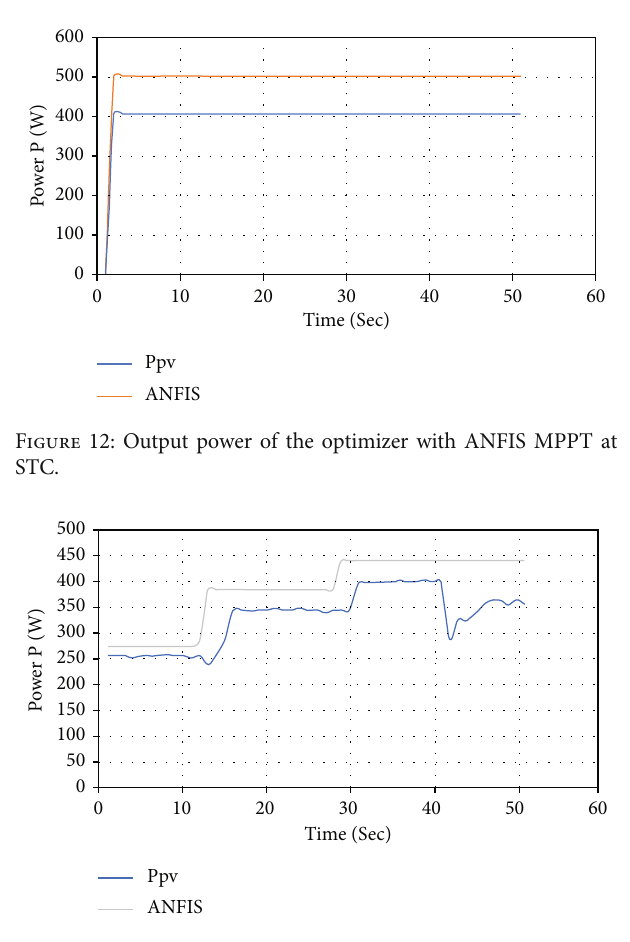
Figure 13: Output power of the optimizer with ANFIS MPPT at